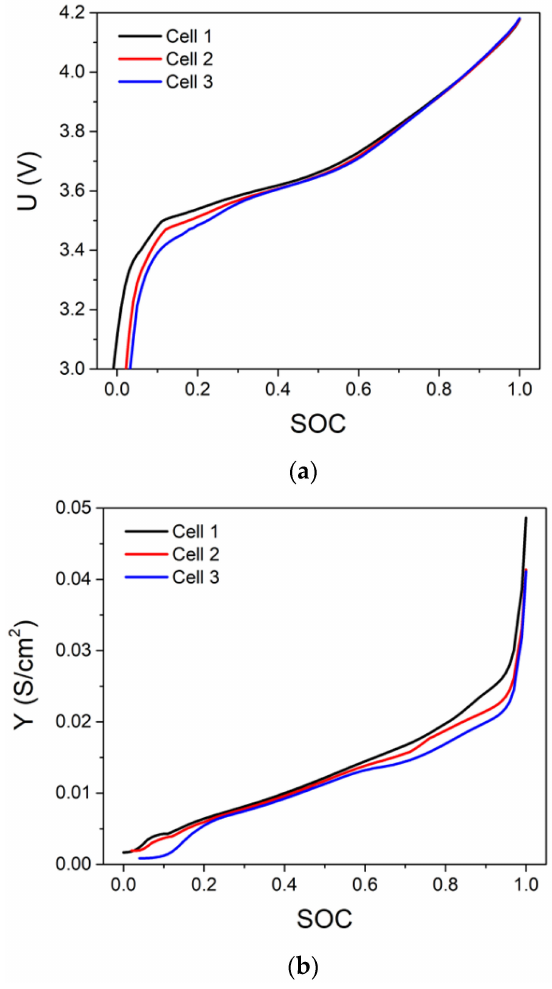
Figure 4. ( a ) U with respect to SOC and ( b ) Y with respect to SOC for cells 1, 2, and 3, having cyclable lithium loss with three levels of electrolyte